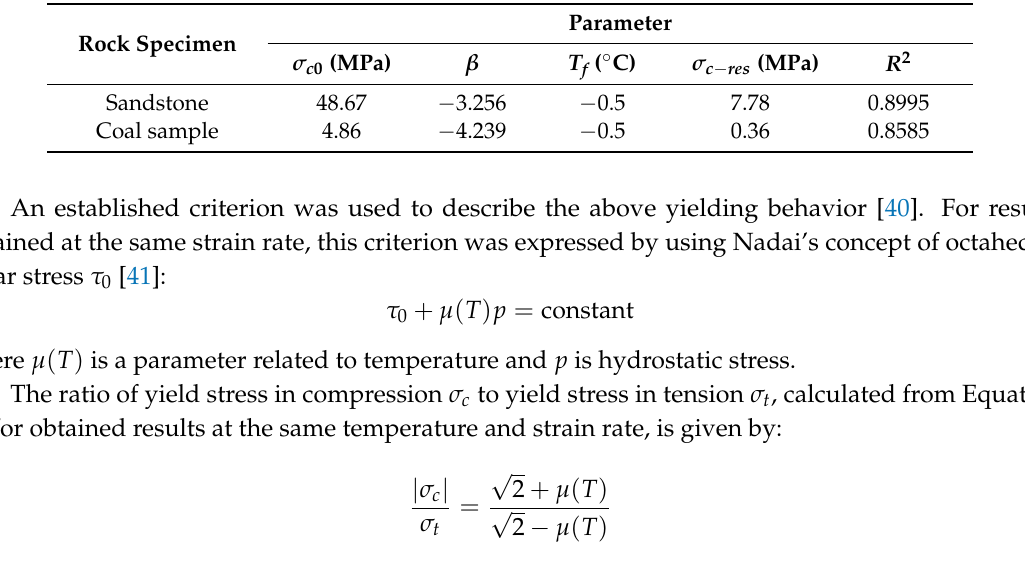
Table 3. Theory parameters (Equation (6)) for uniaxial-compression experiments.